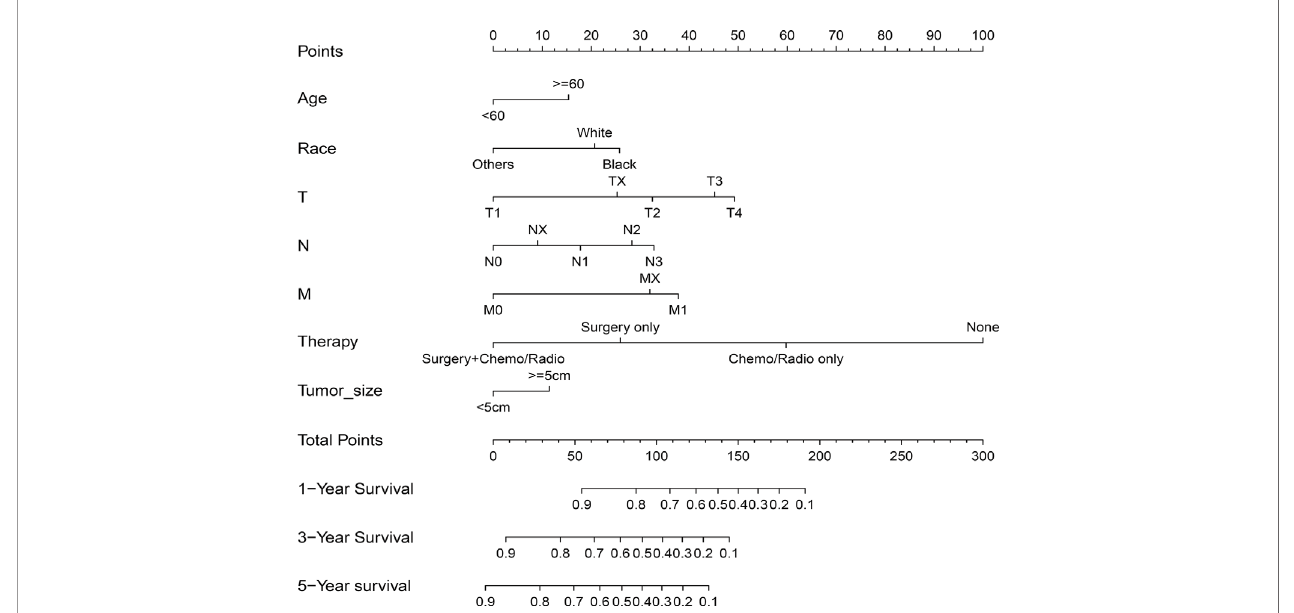
FIGURE 2 | Nomogram predicting 1-, 3-, and 5-year overall survival (OS) for patients with gastric signet ring cell carcinoma (GSRCC). The total points are calculated by summing up the points for each factor. The total points correspond to the patient ’ s 1-, 3-, and 5-year survival probability.